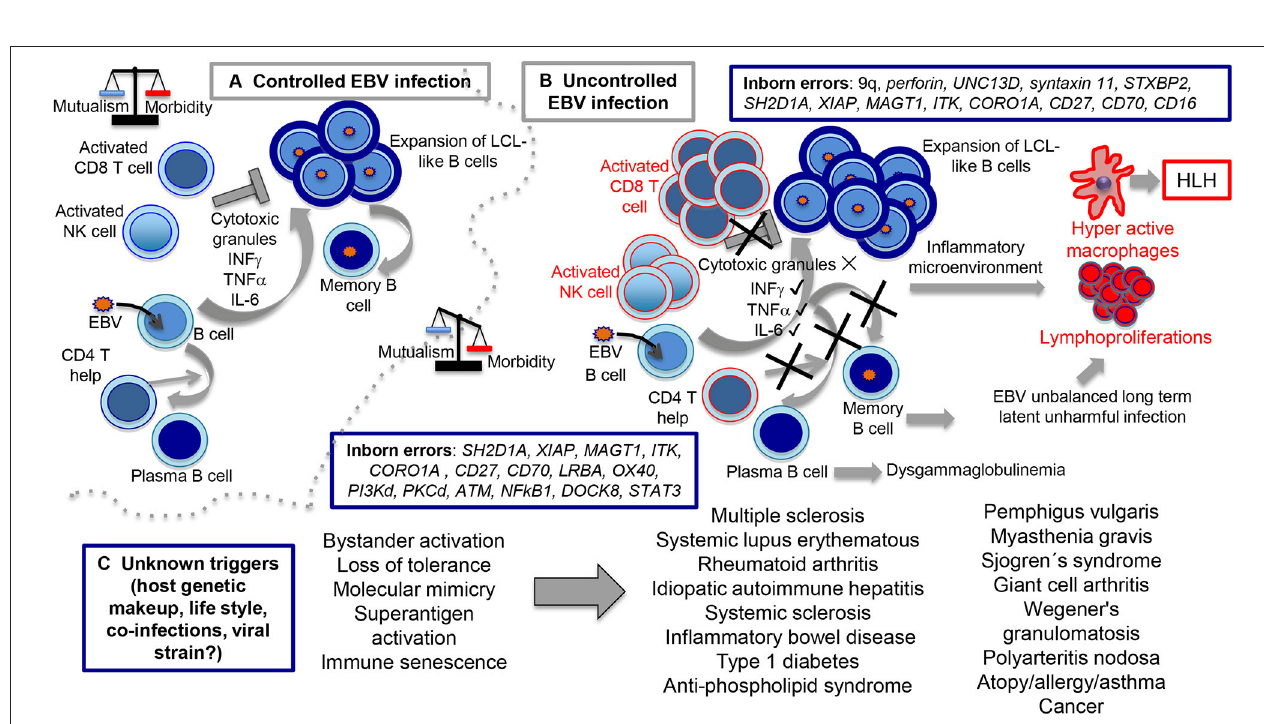
FIGURE 4 | Routes of controlled and uncontrolled infection using EBV as example. In the (A) scenario, EBV has the capacity to induce B cell expansions through formation of germinal center-like reactions and lymphoblastoid-like cells (LCLs). At the end, ad hoc cytotoxic CD8T and NK cell activities directed against the LCL-like cells forces EBV to downregulate viral expression, restricting infection to the memory B cell compartment in which a persistent infection is established. In the (B) scenario, inborn errors interfere with the cytotoxic activity (upper part), resulting in hyperactive CD8T and NK cells still capable to secrete cytokines, such as IFN γ , TNF α , IL-6, and presumably many others, creating the inflammatory microenvironment responsible for macrophages hyperactivity, HLH and lymphoproliferation. On a collateral scenario (lower part of B ), inborn errors that affect CD4T cell function result in impaired T cell-B cell cooperation with diminished formation of terminally differentiated B cells and dysglobulinemia syndromes. Since EBV resides in memory B cells, we hypothesized that this condition unbalances the capacity of EBV to establish unharmful latent infections. In the (C) scenario, still unknown causes tip the balance toward disproportionate bystander activation, loss of tolerance, molecular mimicry, superantigen activation, immune senescence, and perhaps other undocumented mechanisms resulting in inflammatory/autoimmune diseases.